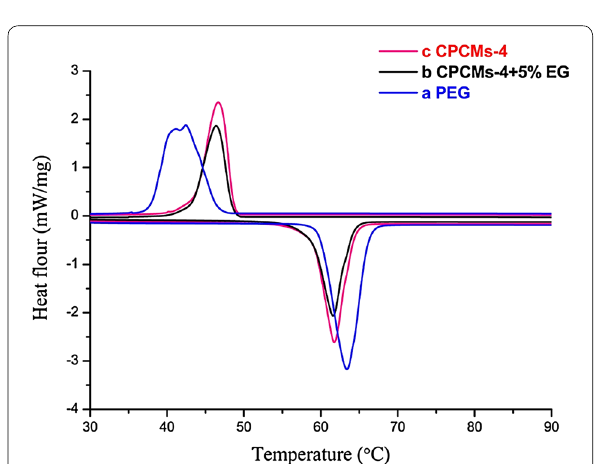
Fig. 10 The DSC curves of (a) PEG, (b) CPCMs‑4 with 5% EG, and (c) CPCMs‑4